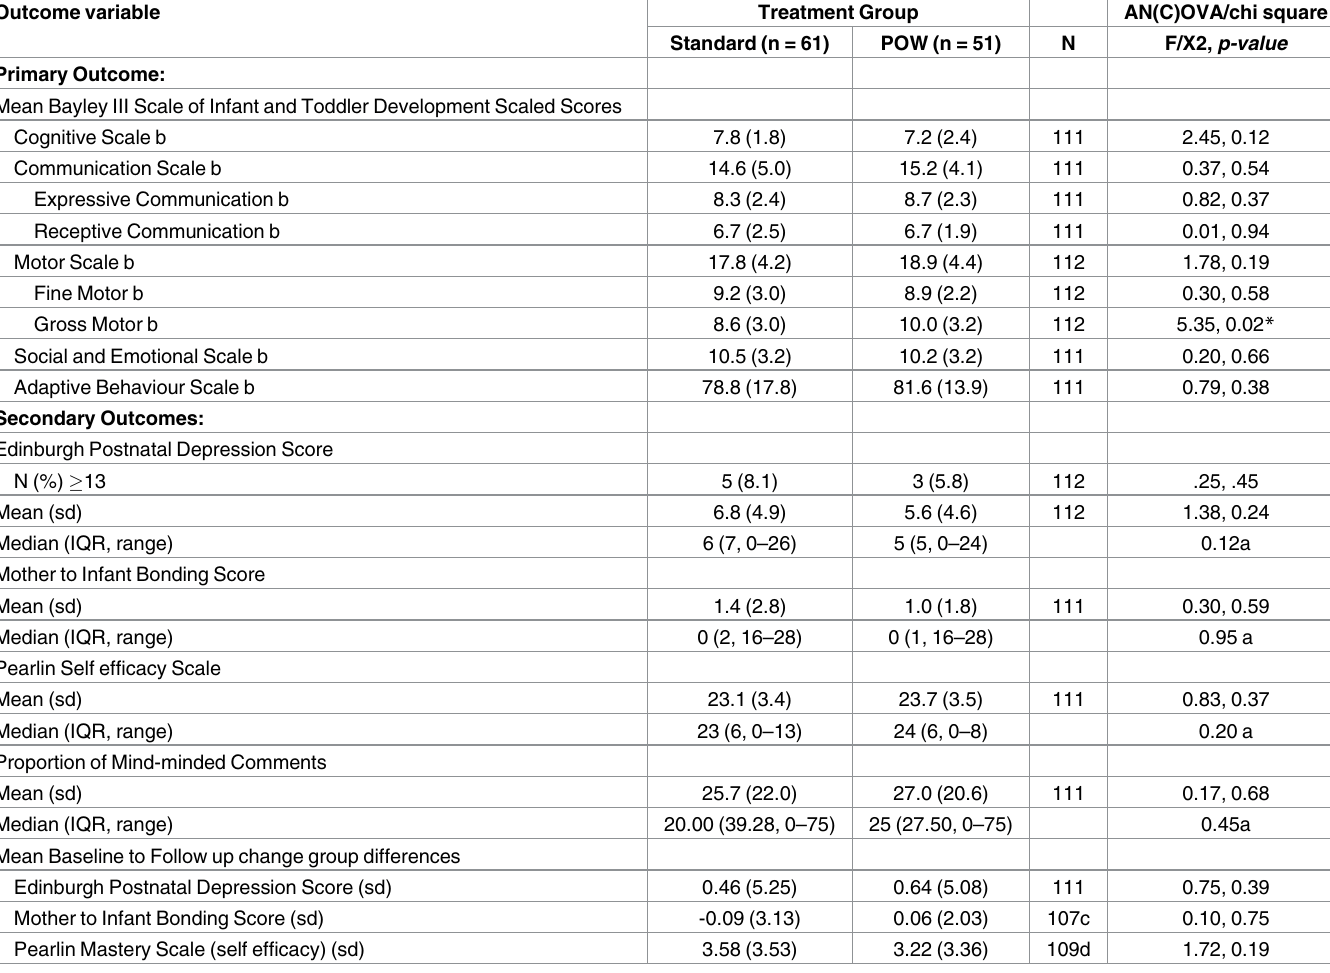
Table 3. Group differences by randomisation in the ELSIPS follow up study at 12 months postpartum. Outcome